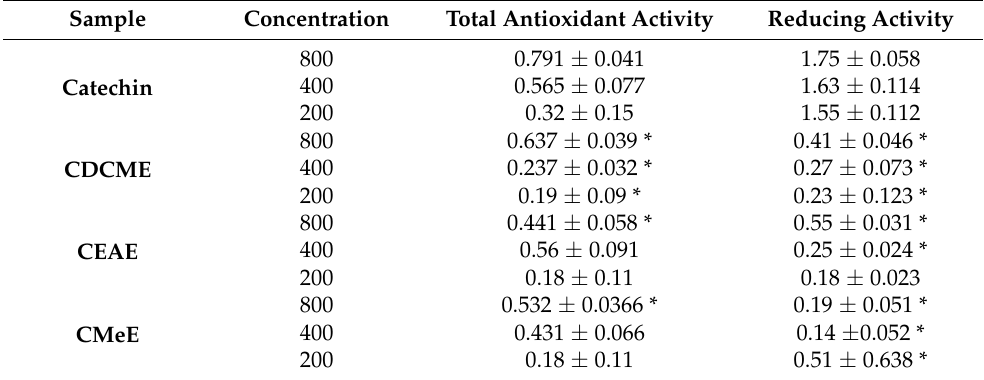
Table 3. Total antioxidant activity and reducing activity of the extracts of Oldenlandia corymbosa L.